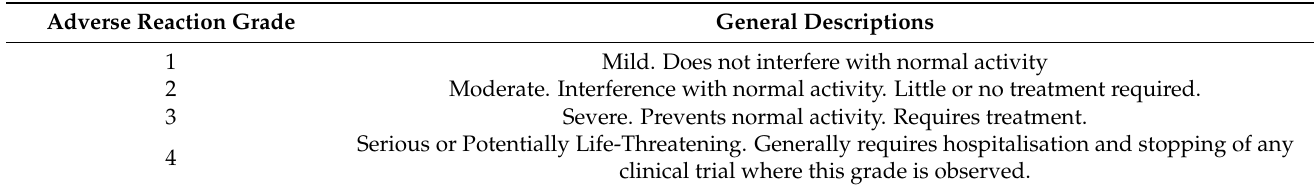
Table 1. Description of adverse event grading in vaccine clinical